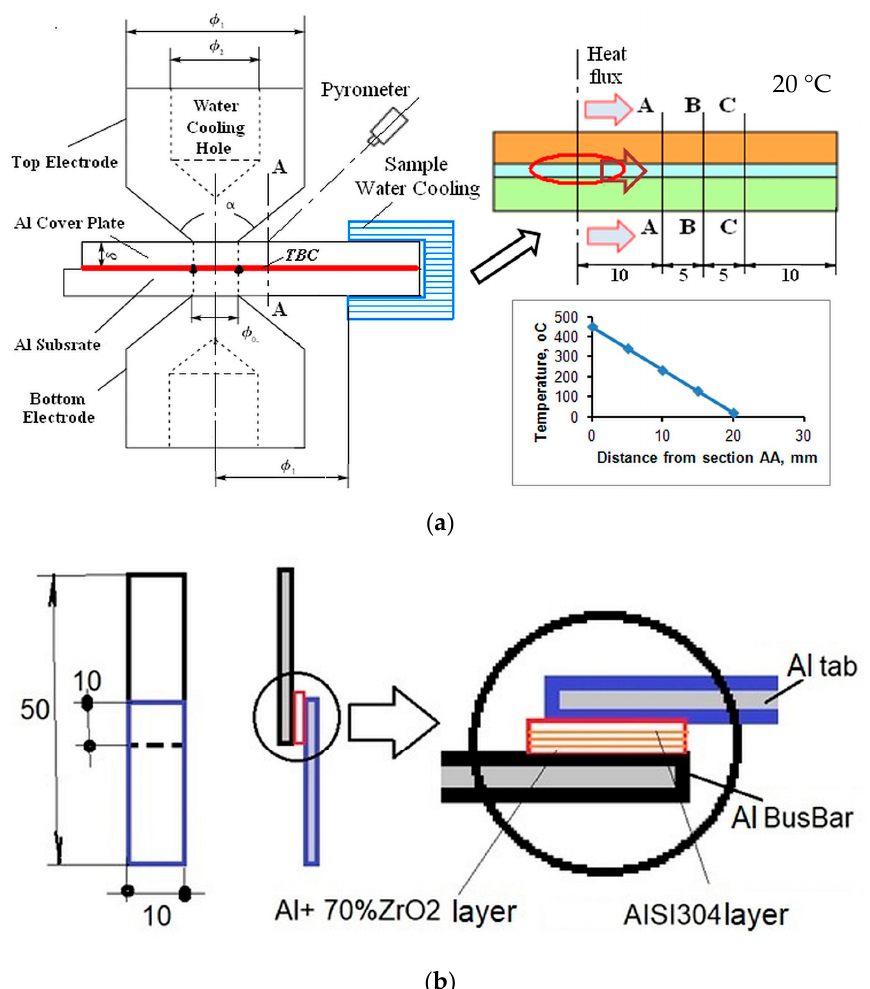
Figure 5. Heat flux tests to examine the TBC thermal fatigue. ( a ) Schematics; ( b ) sample for TBC spot electrical resistance measurements after thermal cycling.